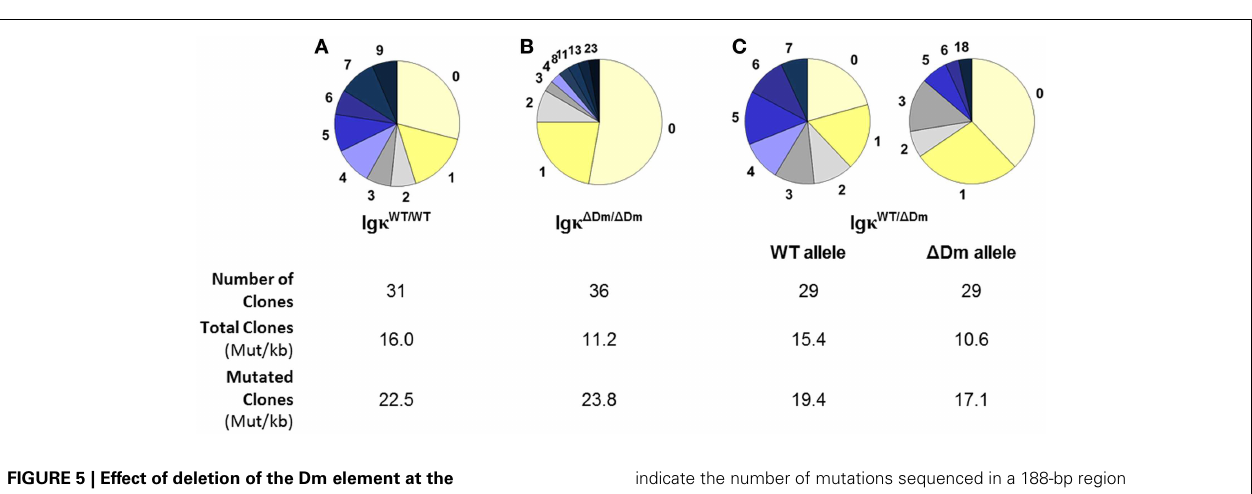
FIGURE 5 | Effect of deletion of the Dm element at the endogenous locus on somatic hypermutations . Somatic hypermutations in B220 + PNA high Peyer’s patches germinal center B cells from (A) Ig κ WT/WT , (B) Ig κ ∆ Dm/ ∆ Dm , and (C) Ig κ WT/ ∆ Dm mice. Pie charts